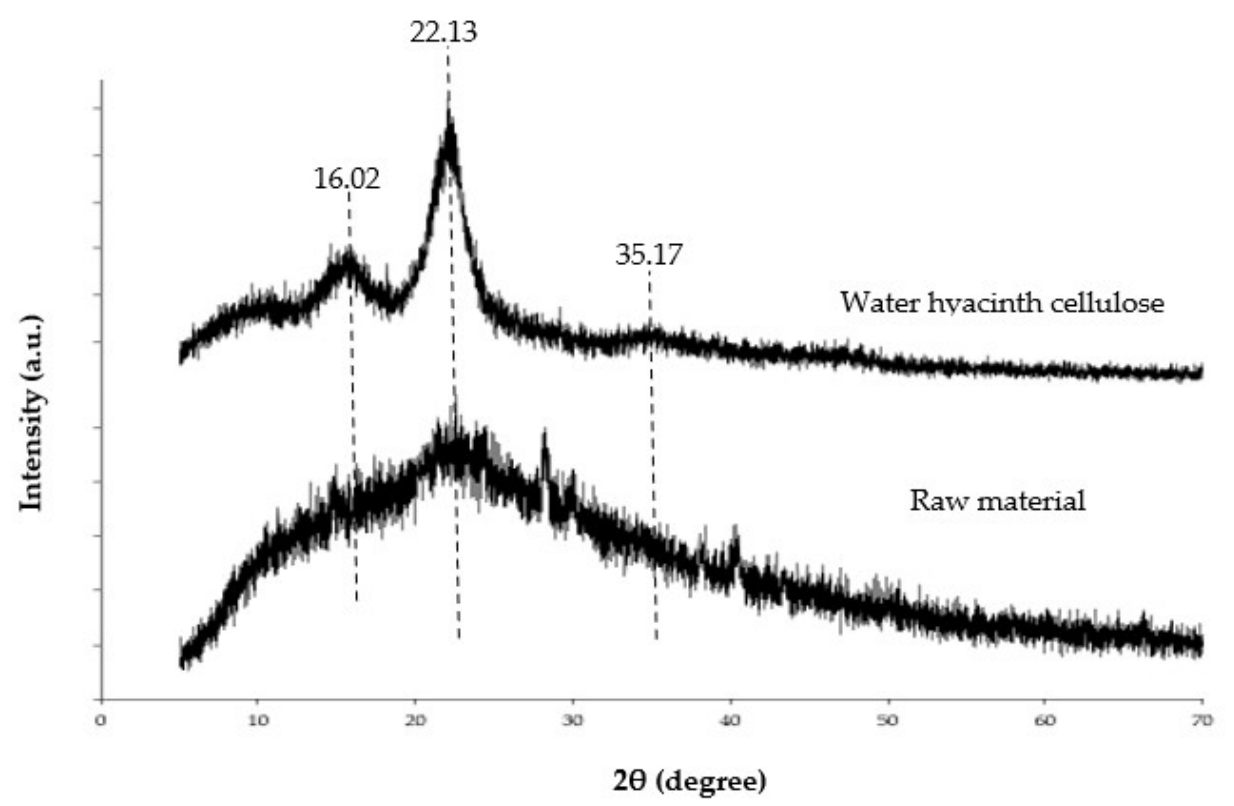
Figure 3. X-ray diffraction of water hyacinth cellulose and raw material.